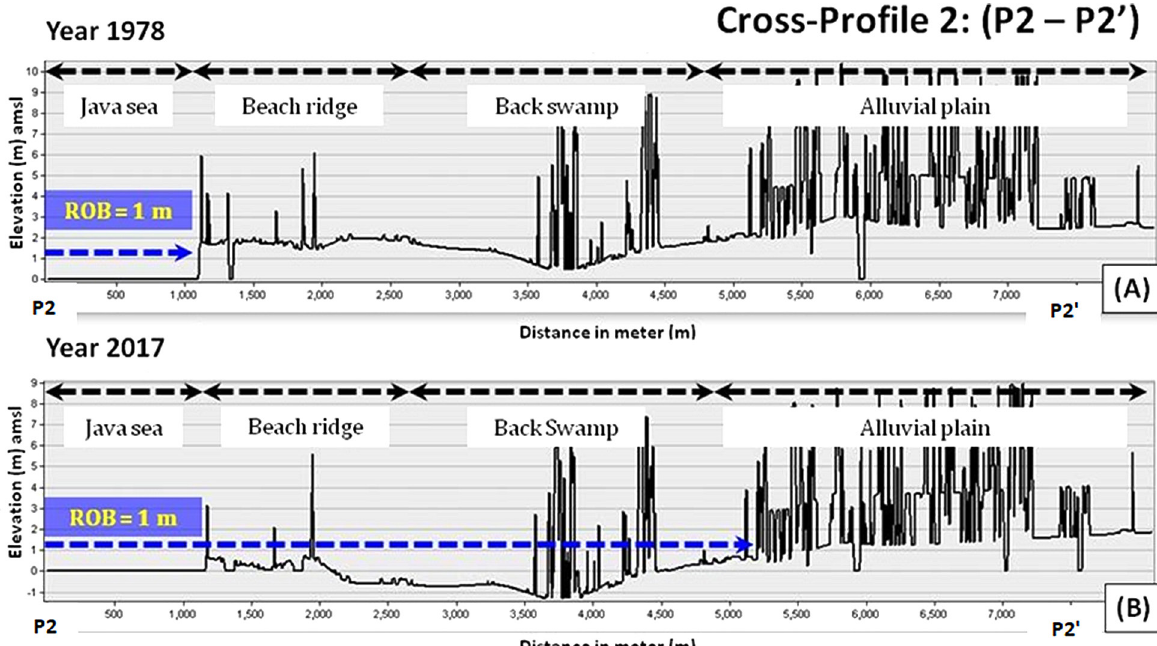
Fig. 9. Comparison results for morphological and topographic condition change from DEM modelling for 1978 and 2017 for cross-profile 2 (P2-P2’) and their implications for vertical tidal flood distribution in coastal landform areas. A. DEM cross-profile 2 in 1978; B. DEM cross-profile 2 in